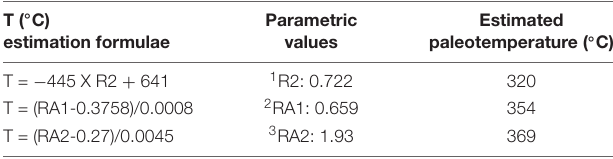
TABLE 2 | Paleotemperature estimation based on Raman parameters. T ( ◦ C) Parametric Estimated estimation